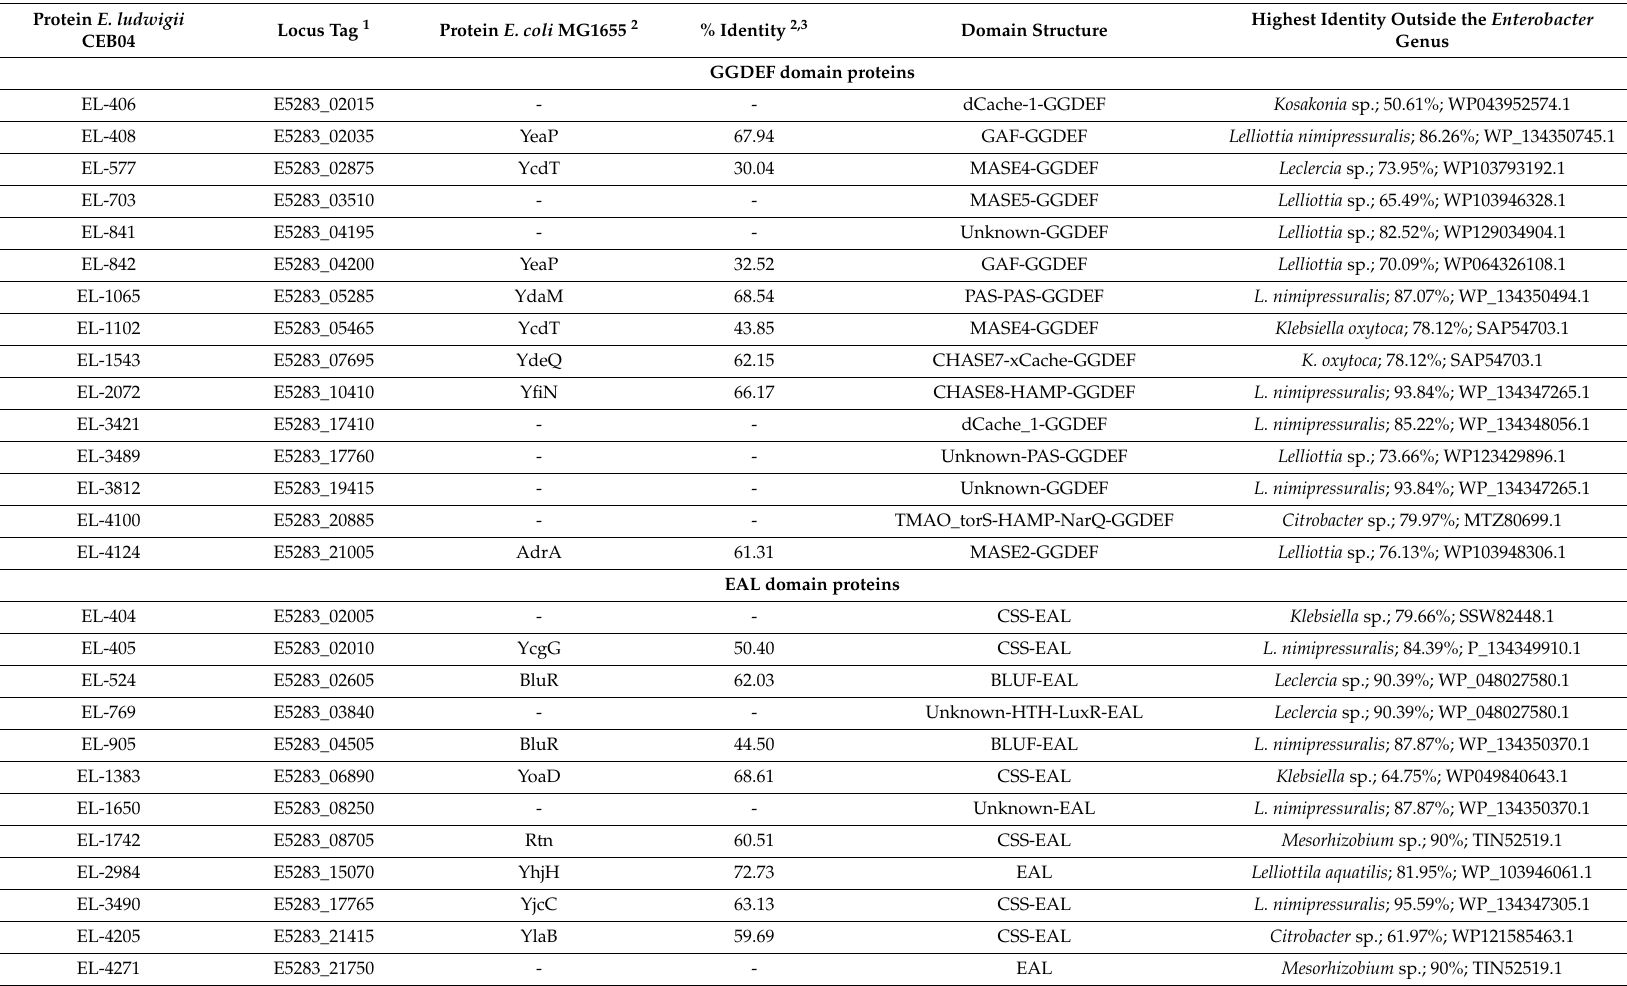
Table 3. List of GGDEF, EAL and HD-GYP domain proteins in E. ludwigii CEB04. Protein E. ludwigii